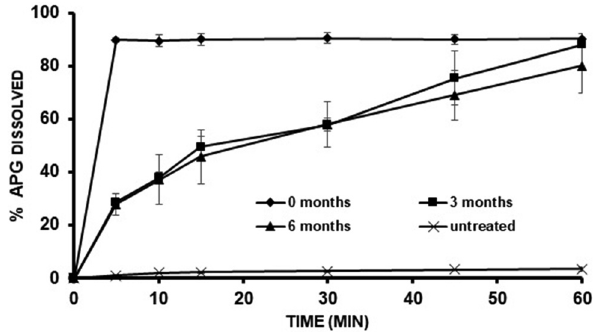
Figure 9: Dissolution pro fi le of APG nanoparticles at initial nano - particles, 3 months stability, and 6 months stability compared to untreated